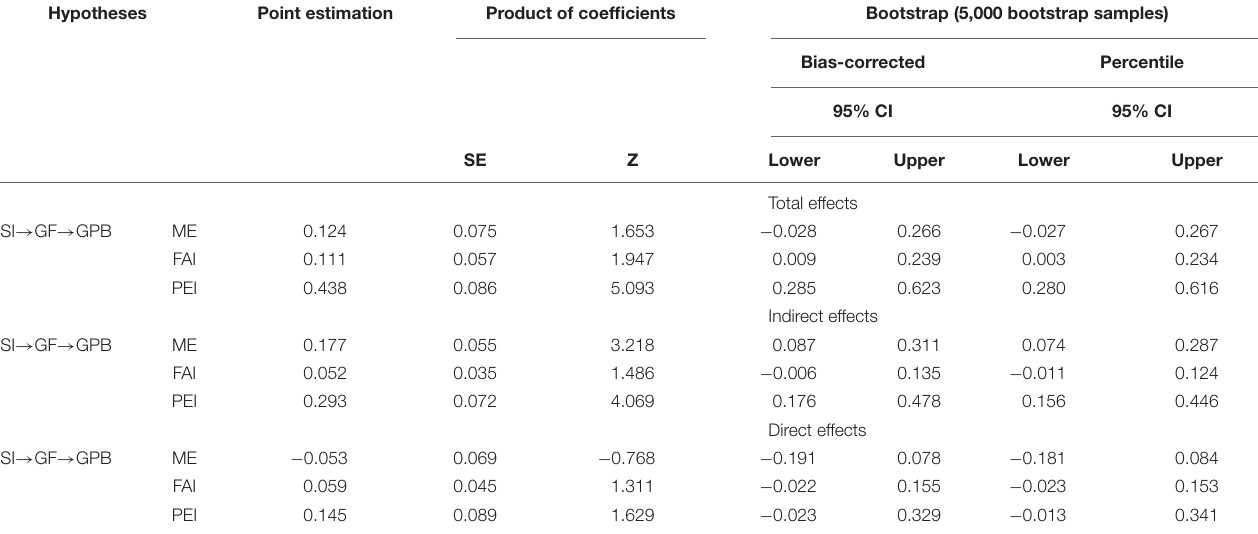
TABLE 2 | The results of total mediated effects with bootstrapping approach.